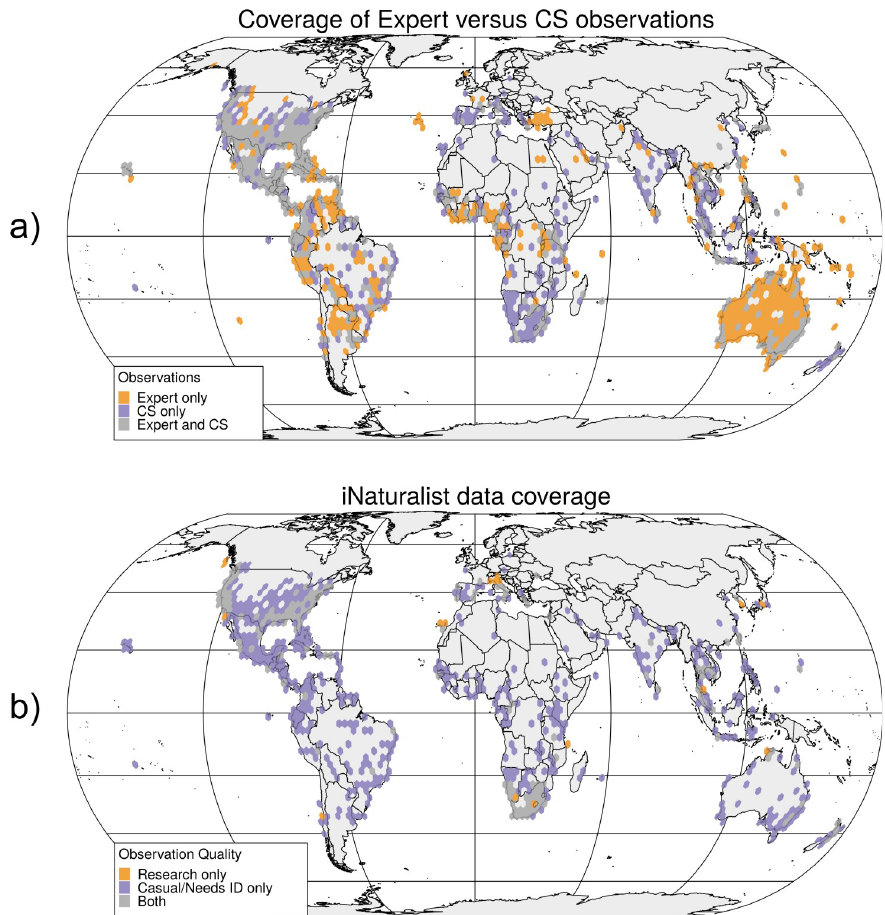
Fig 3. Coverage of termite observations from the three analyzed sources separated into CS-based and expert based (a), and coverage of iNaturalist records alone, separated by observation quality (b).